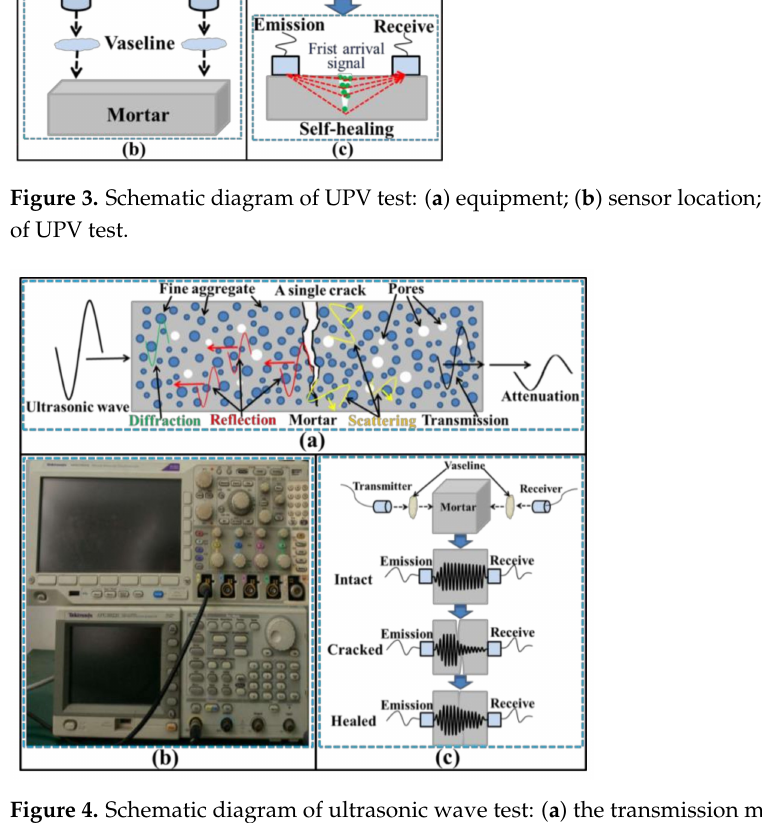
Figure 4. Schematic diagram of ultrasonic wave test: ( a ) the transmission mechanism of ultrasonic wave in concrete, ( b ) equipment, and ( c ) the wave